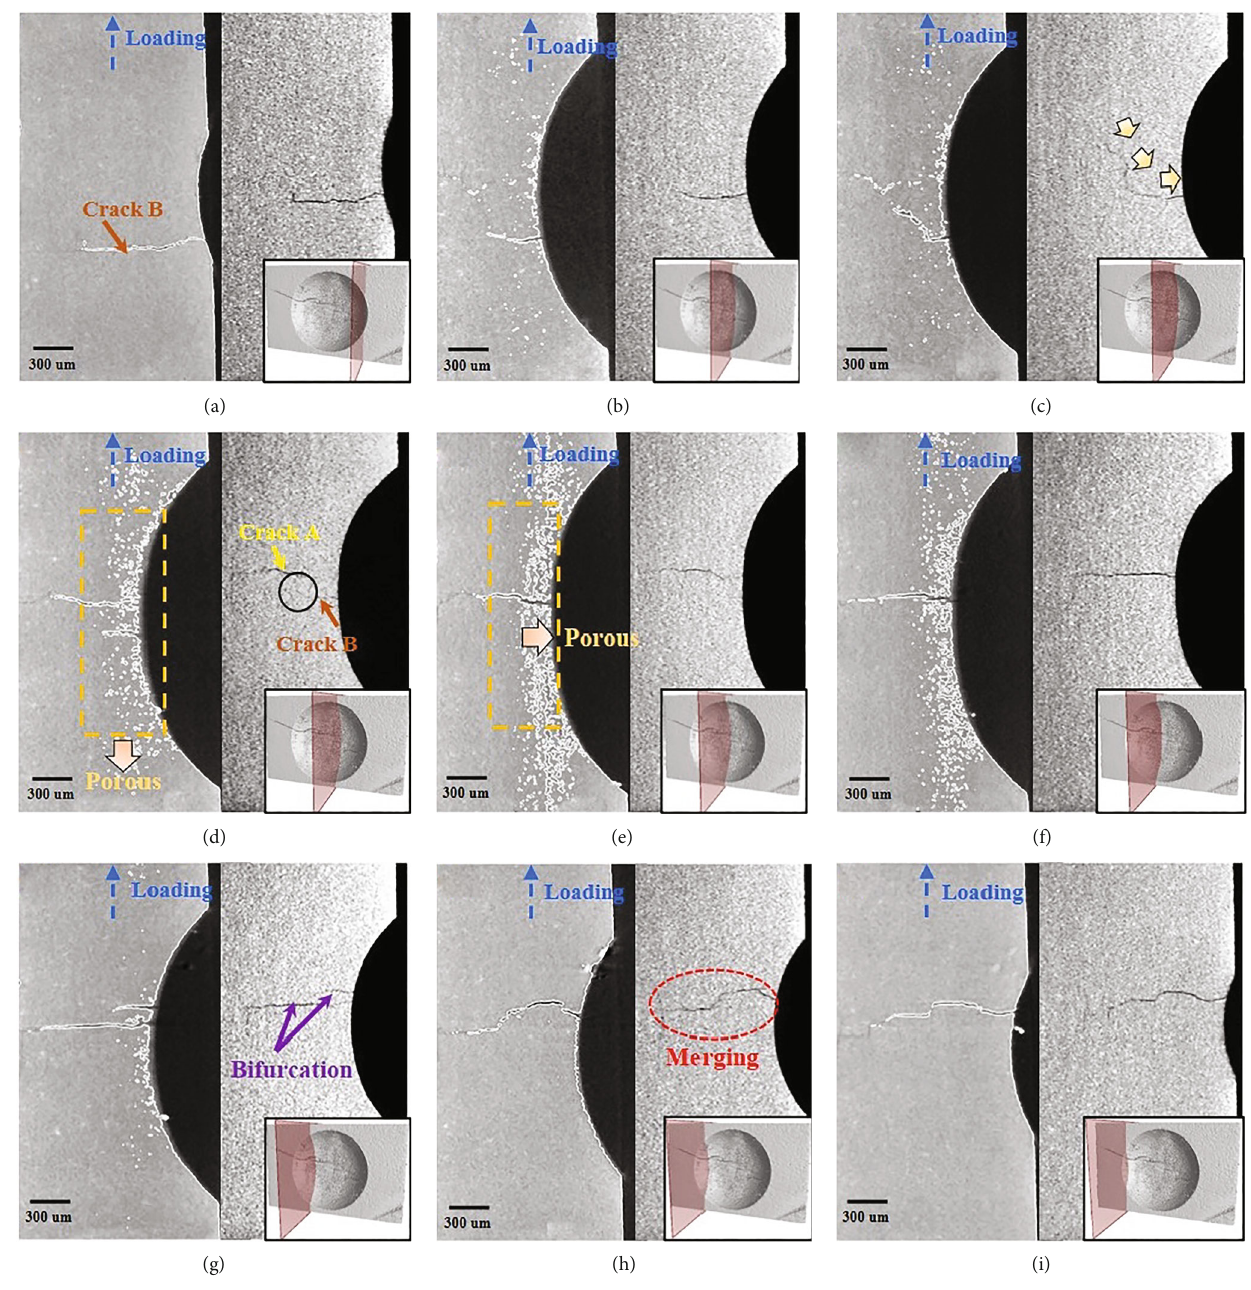
Figure 10: Side views in various scanning planes along the transverse